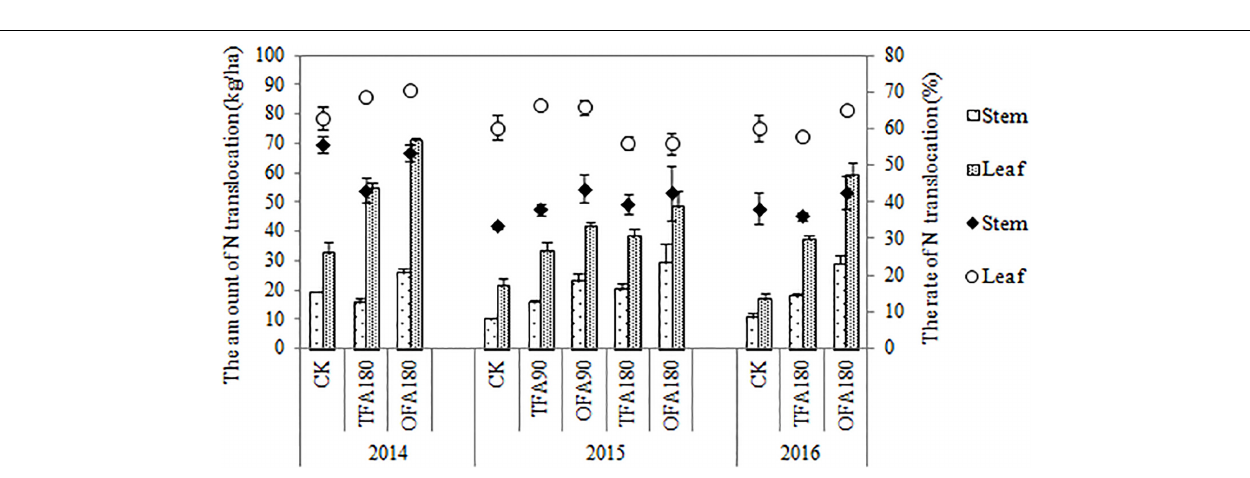
FIGURE 4 | Differences in the quantities and rates of nitrogen translocation. CK: no nitrogen applied; TFA: traditional nitrogen fertilizer application; OFA: optimized nitrogen fertilizer application; 90: total nitrogen application rate of 90 kg ha - 1 ; 180: total nitrogen application rate of 180 kg ha - 1 . Data represent mean values of three biological replicates ±